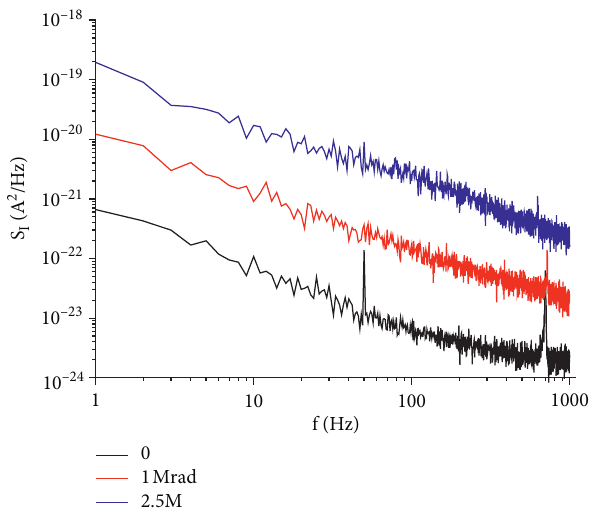
Figure 3: Current noise spectral density during radiation for various total doses.